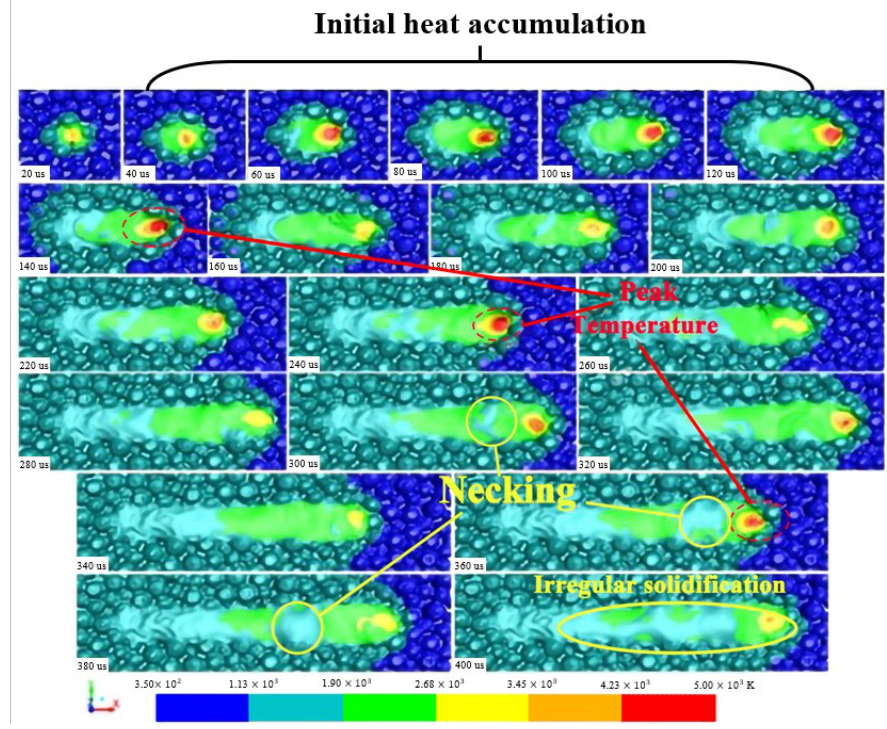
Figure 13. Change in temperature distribution and surface morphology of the melt pool of one single-track scanning with time.